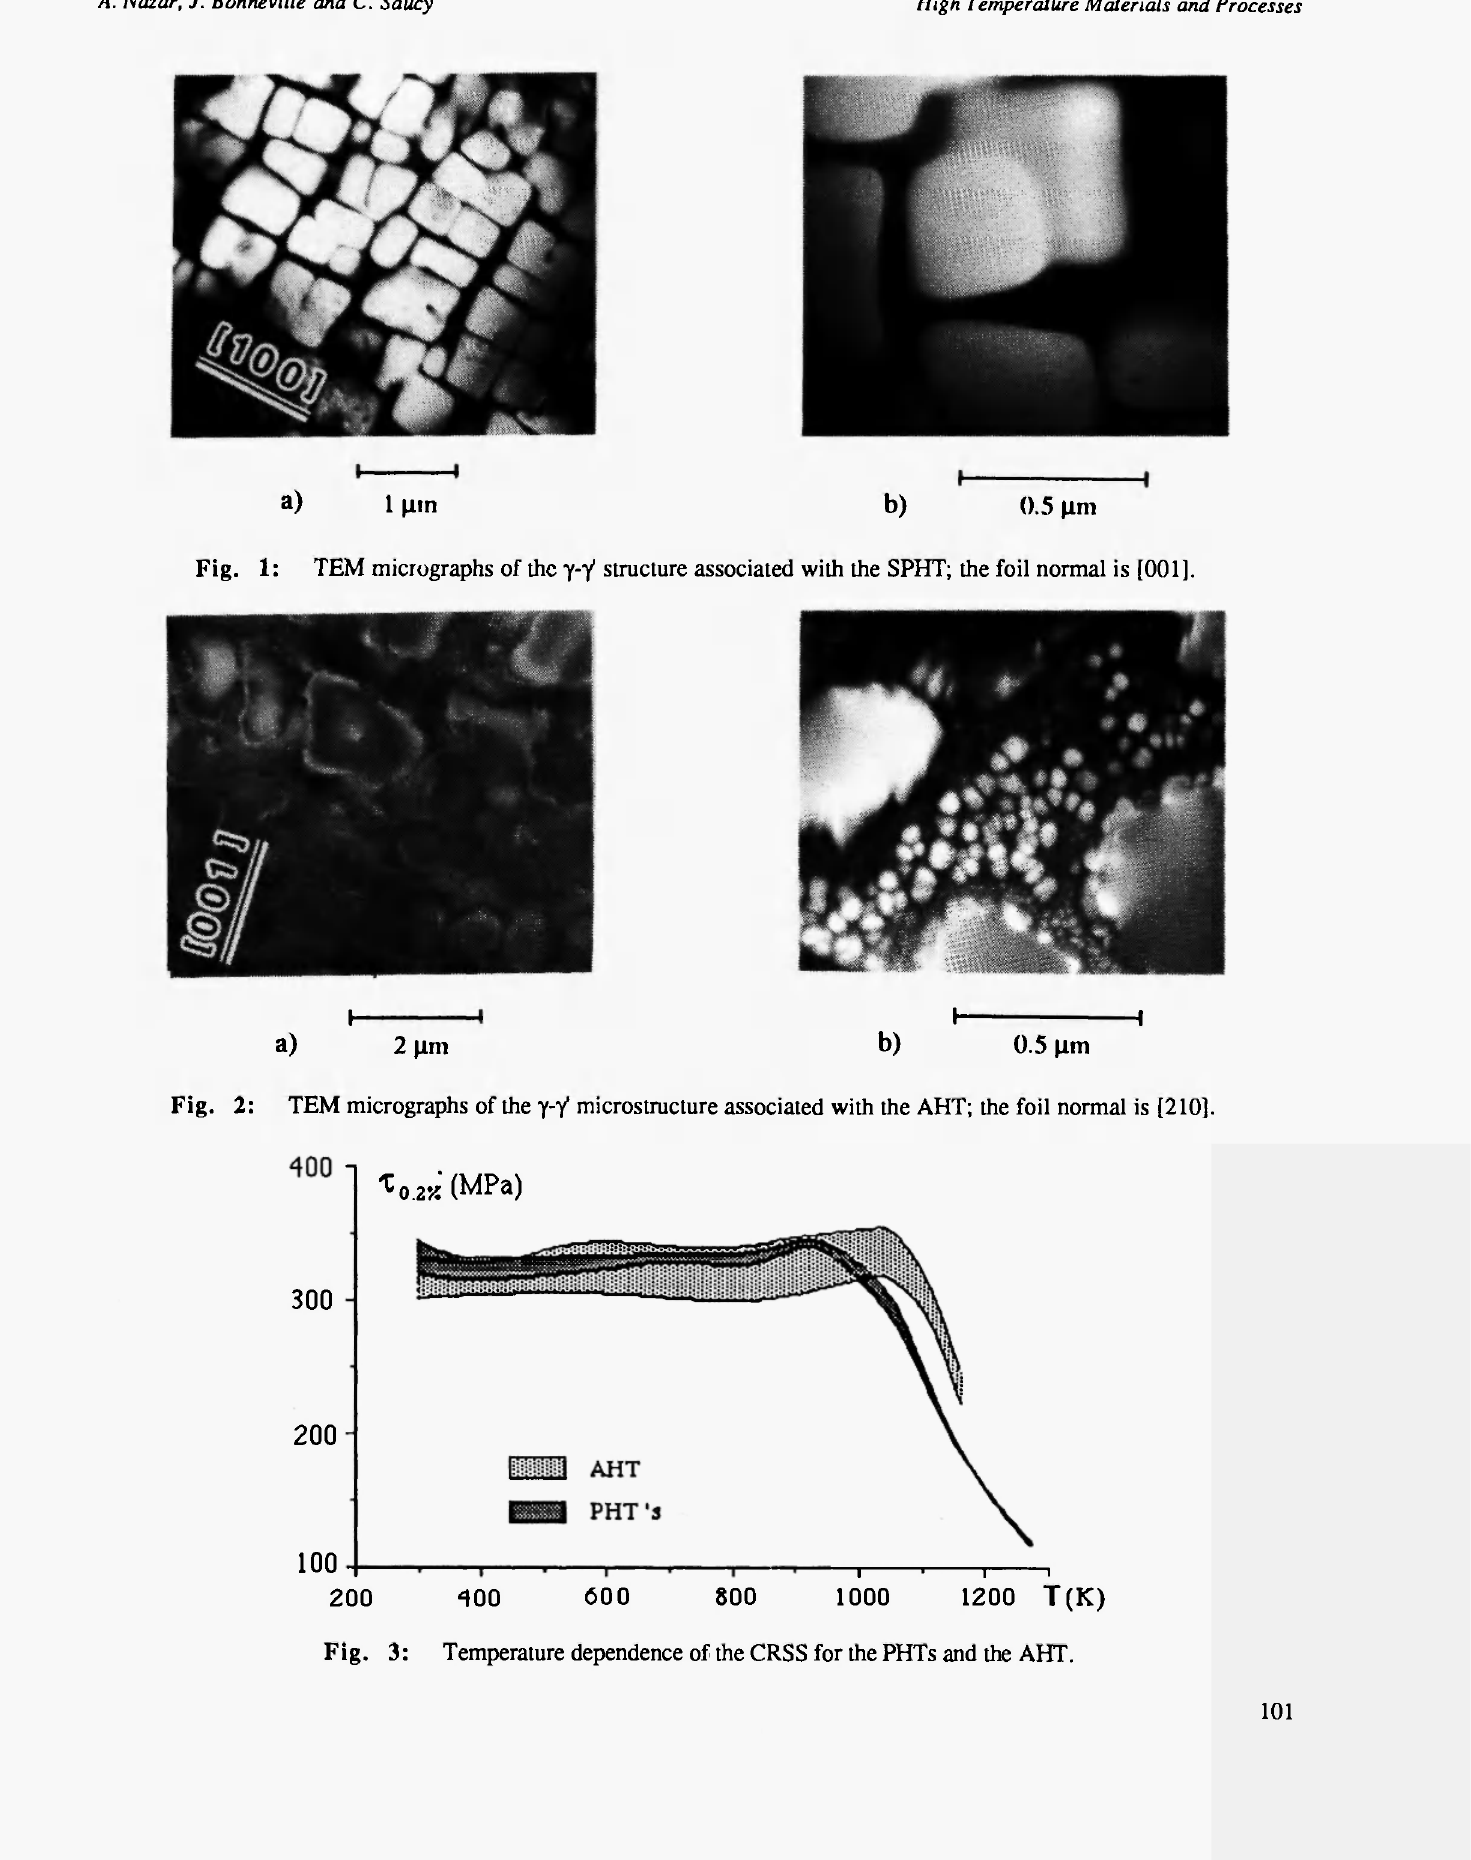
Fig. 3: Temperature dependence of the CRSS for the PHTs and the